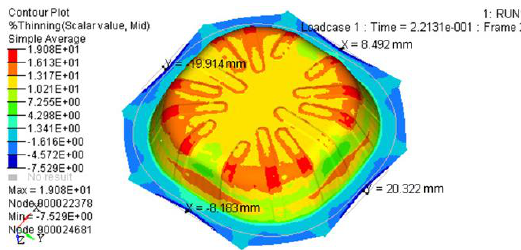
Figure 12. % Thinning distribution and X1, X2, Y1 and Y2 values for the RUN11; blank1.